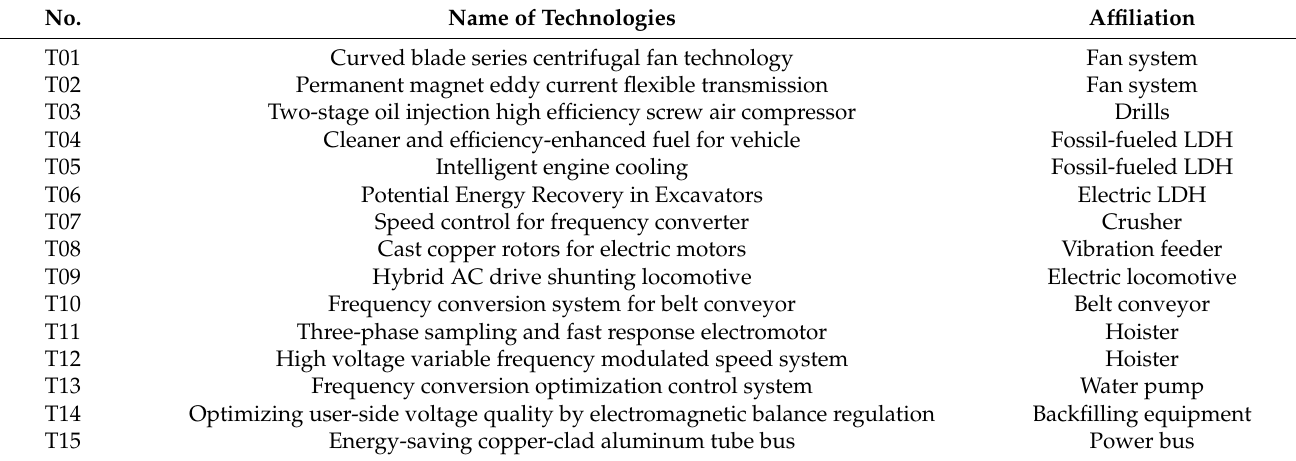
Table 1. Energy conservation and carbon abatement technologies.